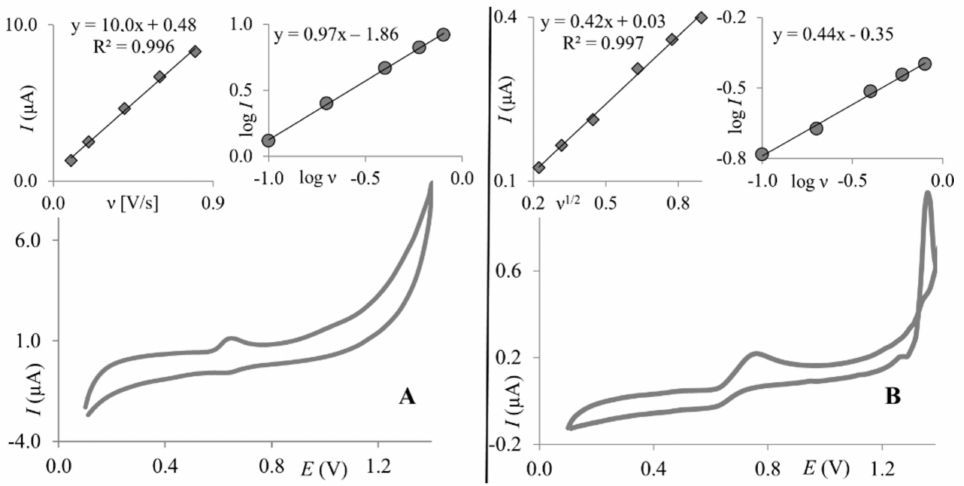
Figure 3. Cyclic voltammograms (scan rate 50 mV × s − 1 ) of 1.0 × 10 − 5 mol L − 1 PA were recorded on ClPE ( A ) and GrPE ( B ). Insets: the relationship between PA peak current and scan rate ( A -left) or the square root of scan rate ( B -left); the relationship between the logarithm of PA peak current and logarithm of scan rate ( A -right, B -right).